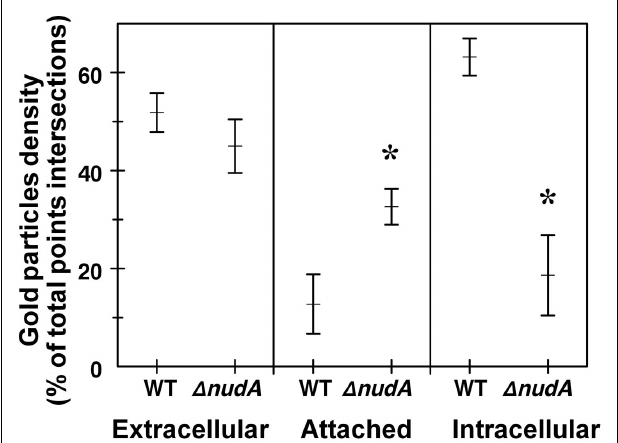
FIGURE 9 | Role of H. pylori NudA invasin inAGS cell entry determined using the gentamicin protection assay aided byTEM and anti- H. pylori antibody immunogold. H. pylori density is expressed as the percentage of total points intersections that were immunogold-positive (see Materials and Methods).Values are Means ± SEM. Left panel shows that the extracellular density of H. pylori WT and Δ nudA were not significantly different. In contrast, the middle and right panels show that the density of WT H. pylori attached to AGS cell membranes was significantly lower than that of the Δ nudA mutant (* p < 0.01) and the opposite relation for the density of intracellular H. pylori (* p <